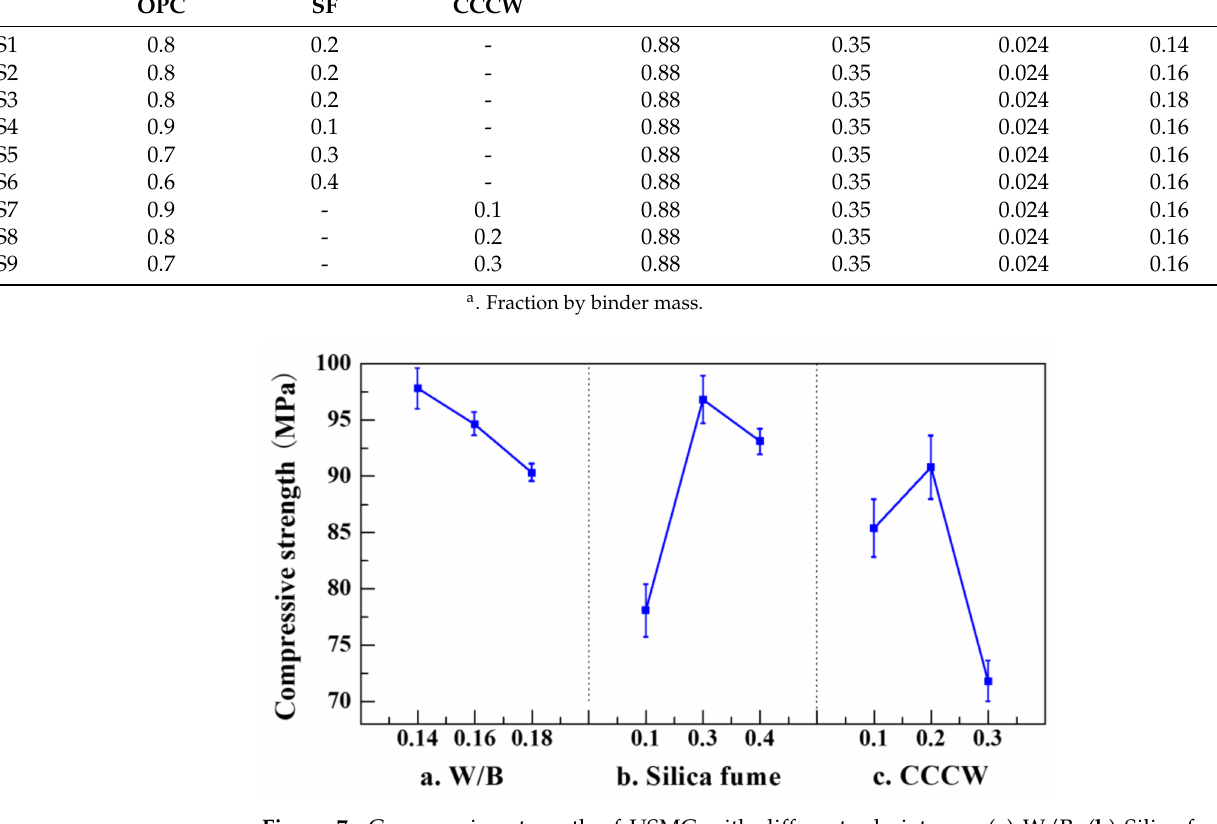
Figure 7. Compressive strength of USMC with different admixtures: ( a ) W/B, ( b ) Silica fume,